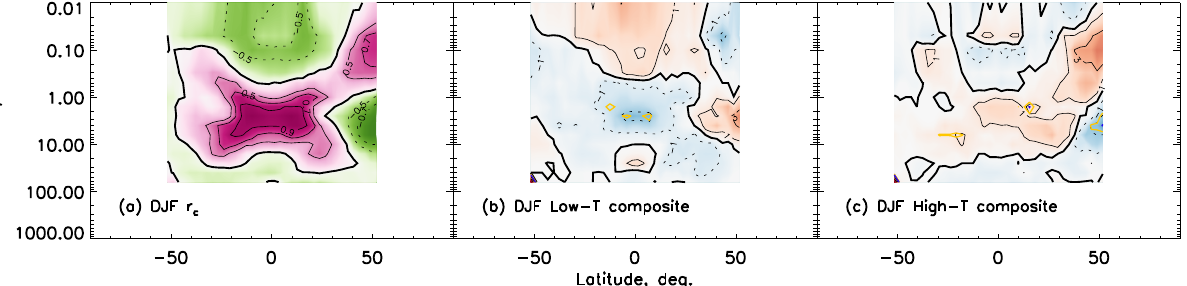
Figure 4. (a) SABER temperature data correlation coefficient map of zonal-mean 20 ◦ N–20 ◦ S 2.5hPa anomalies with all latitudes and altitudes for all low- and high- T DJF events. Composite temperatures for DJF (b) low- T and (c) high- T events, as defined in Fig 2. Shading colours and black contours are the same as in Fig. 3 (dashed: negative; solid: positive; thick: 0). Signals at 2 standard deviations from 0 are given as yellow contours in (b) and (c)